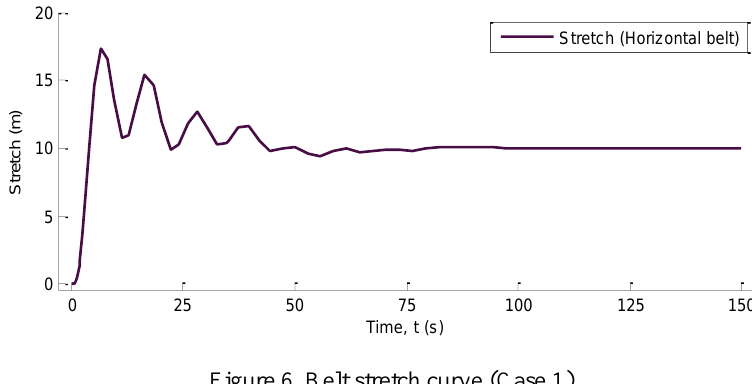
Figure 6. Belt stretch curve (Case 1)